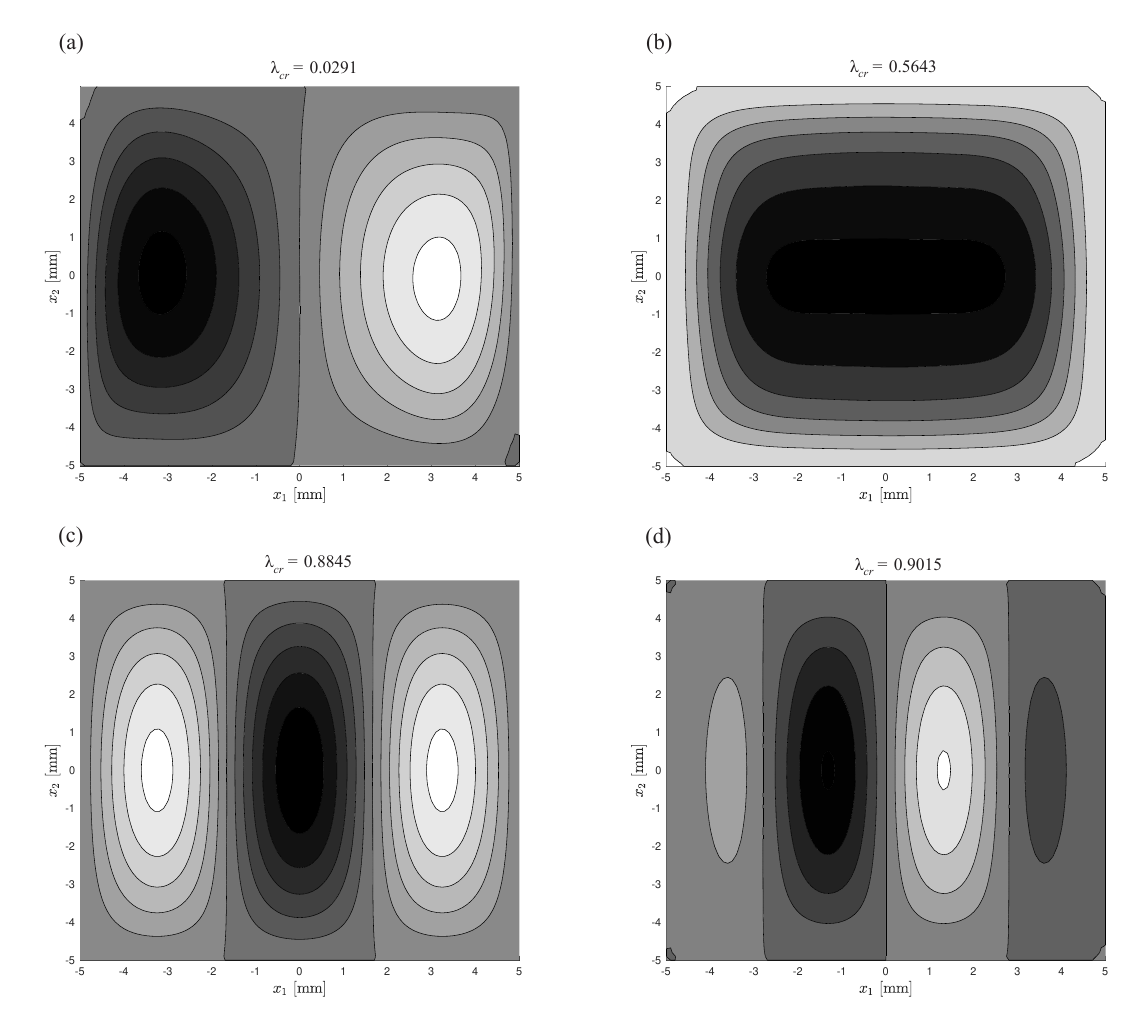
Fig. 5. Buckling mode shape for sandwich S1 (a–b) and sandwich S2 (c–d) under uniaxial compressive